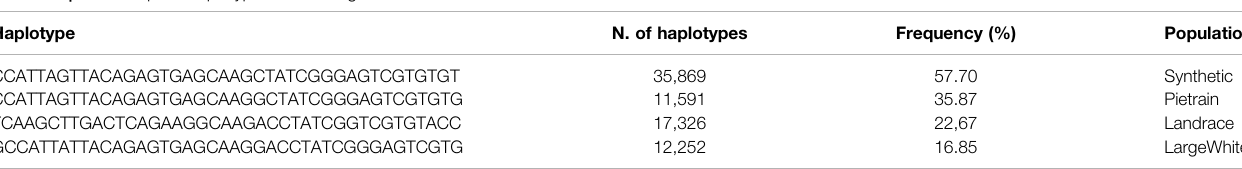
TABLE 5 | Most frequent haplotypes decreasing